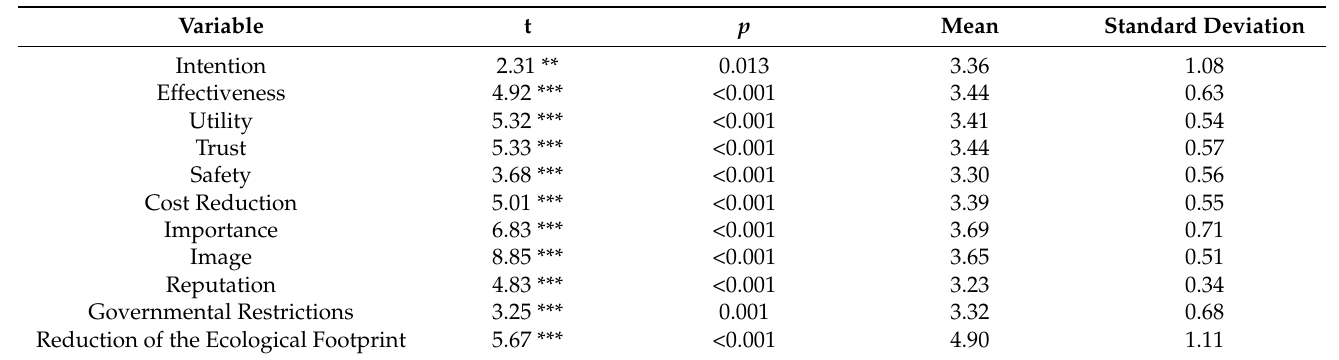
Table 1. Descriptive statistics of the variables under study. Source—IBM SPSS Statistics v.28.0.0.